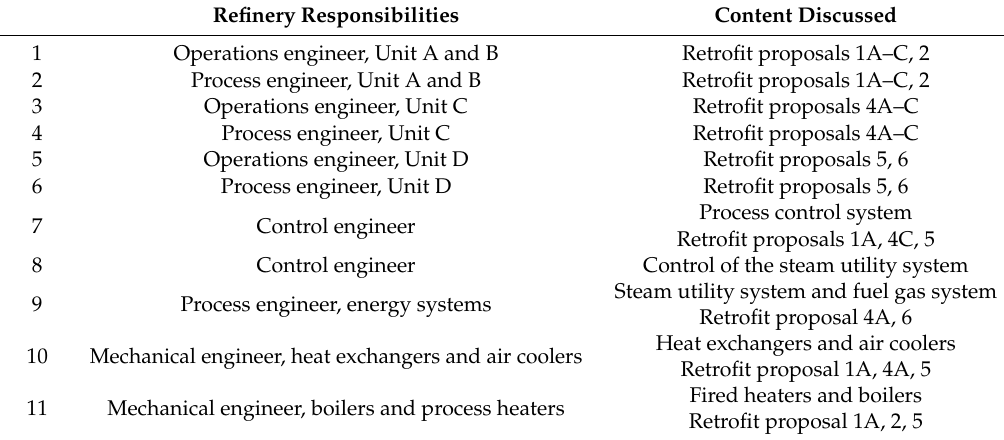
Table 4. List of interviewees and content discussed in the